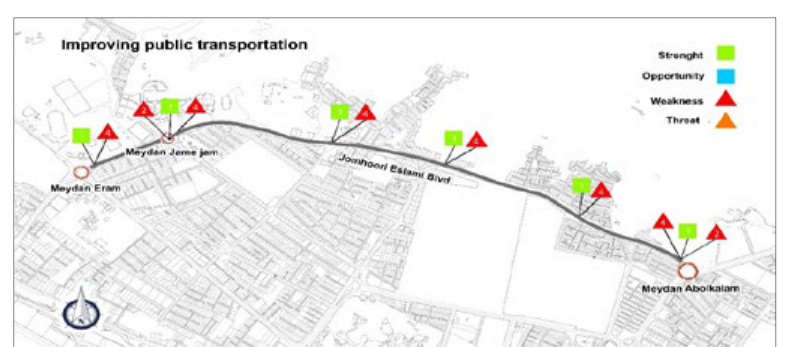
Fig. 5. Improving public